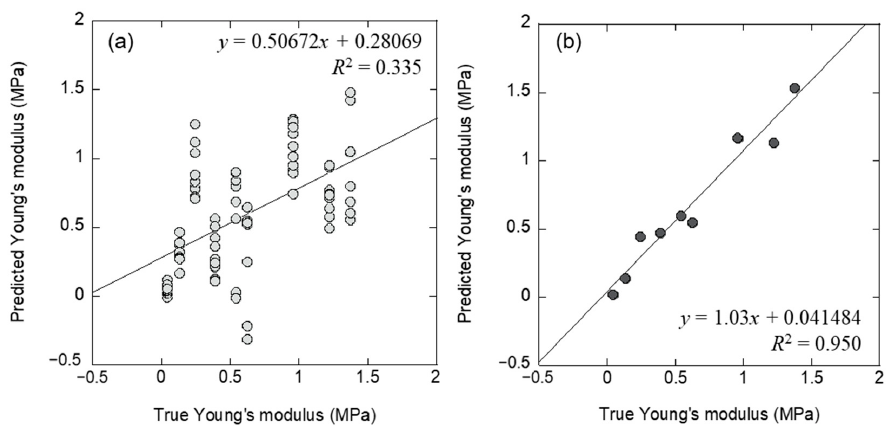
Figure 7. Prediction results of Young’s moduli of agarose samples using machine learning-based Appl. Sci. 2023 , 11 , x FOR PEER REVIEW analysis with ( a ) non-averaged data and ( b ) averaged data. Table 1. Prediction results of Young’s modulus by machine learning-based analysis in Figure 7b. Actual Values in True and Predicted Young’s Modulus